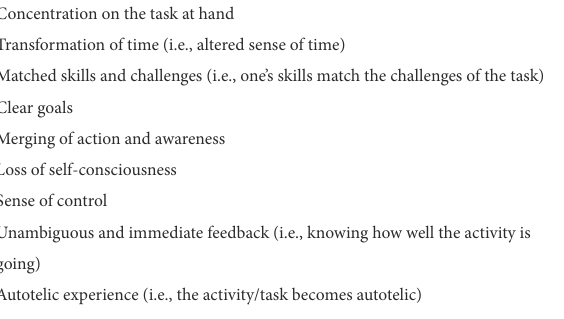
TABLE 1 Dimensions of flow